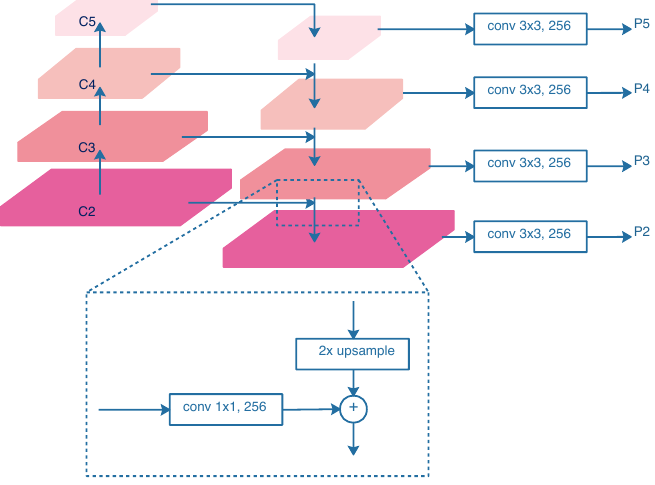
Figure 3. Overall framework of MSR2N.